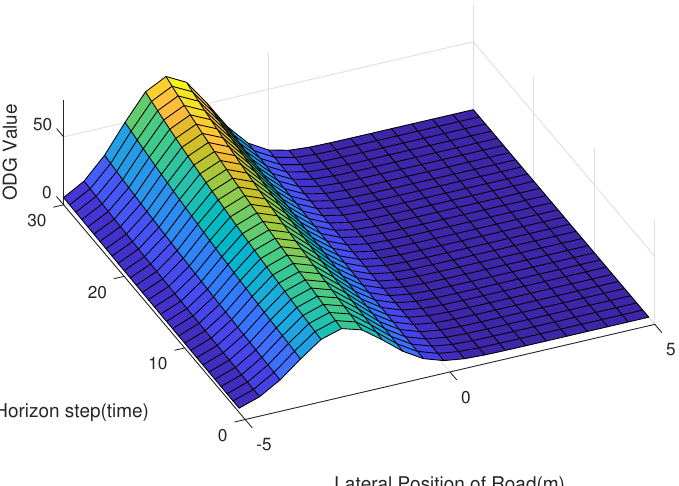
Figure 12. Vehicle obstacle-dependent Gaussian (ODG) with model prediction control longitudi- nal position.